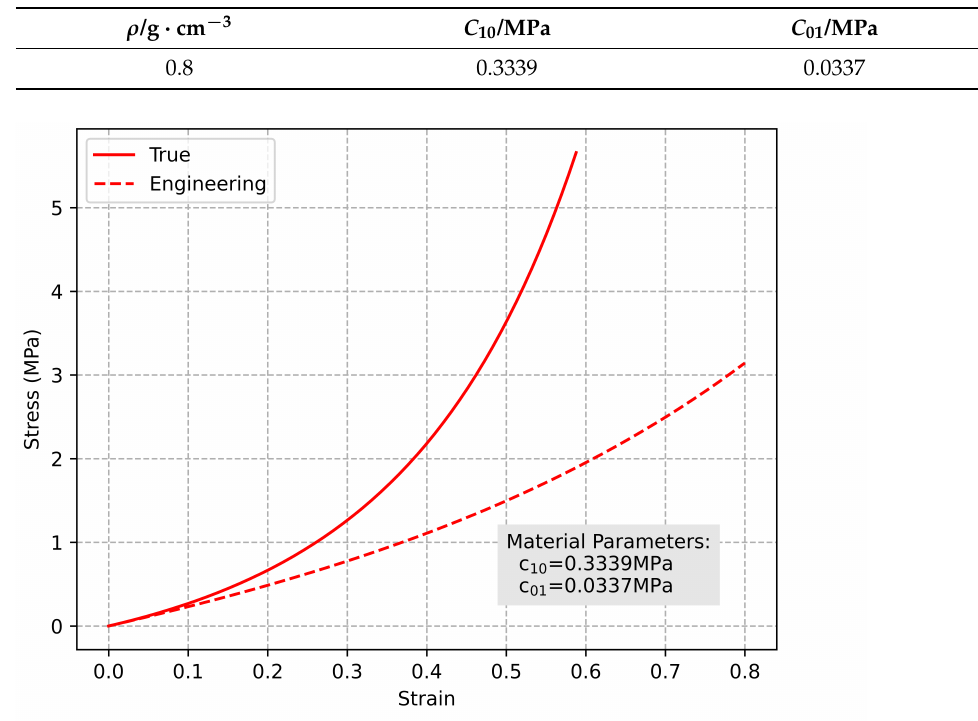
Table 1. Material parameters of the O-ring.